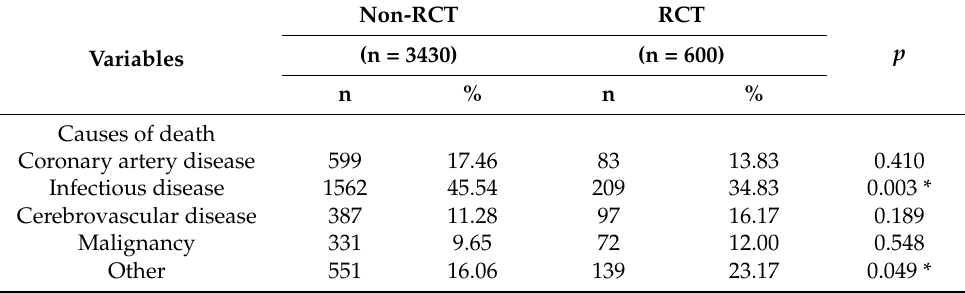
Table 5. Cause of